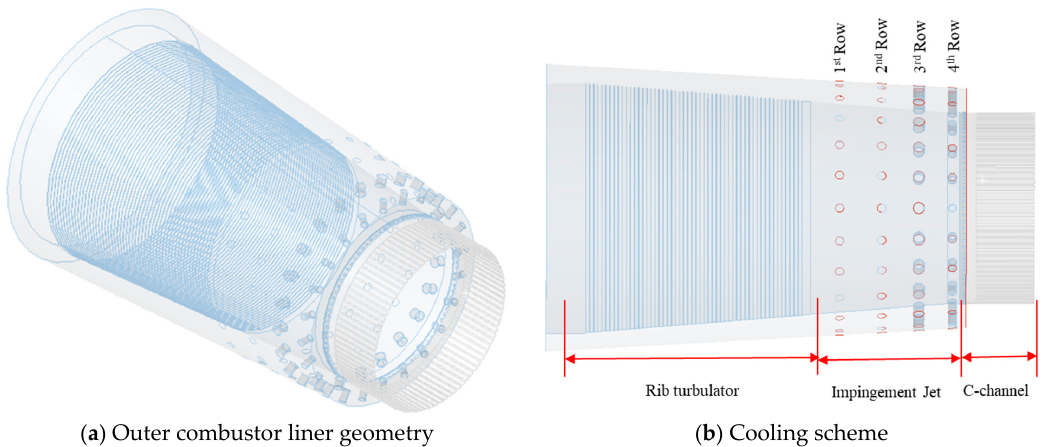
Figure 5. Simulation model of the cooling flow only between CL and flow sleeve for model-2. Table 2. Boundary condition for cooling flow simulation in model-2 .